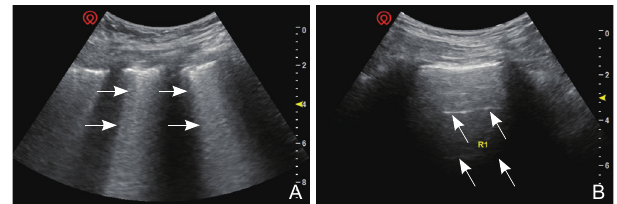
Figure 1 The tele-ultrasound images of the lung. (A) On the first day in the hospital, the lung ultrasound revealed multiple B3-lines (arrows) in bilateral lung particularly in 4th-6th zones and fused to “white lung”. Diffuse atelectasis appeared; (B) On the 24th day in the hospital, the lung ultrasound revealed multiple A-lines (arrows) appeared in bilateral pulmonary areas, pleural effusion disappeared.